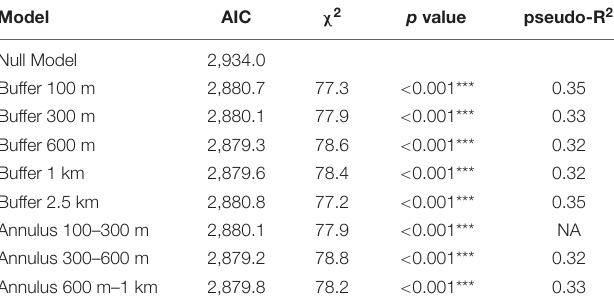
TABLE 1 | Results of model (dependency of Hesperomyces virescens prevalence on Harmonia axyridis on coloration and climate and habitat properties) evaluation showing candidate models being significantly better than the null model and estimated pseudo-R 2 values indicating model